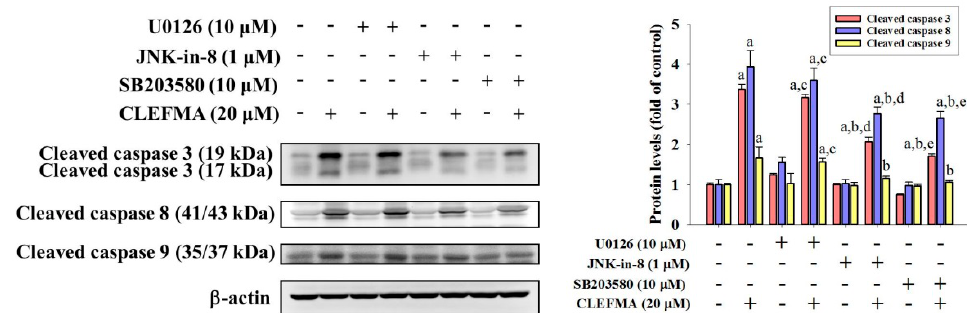
Figure 6. Effects of CLEFMA and inhibitors of ERK1/2 (U0126), JNK1/2 (JNK-in-8), and p38 (SB203580) on cleaved caspases 3, 8 and 9 expression of U2OS cells. Expressions of cleaved caspases 3, 8 and 9 after pretreatment with or without 10 μ M of U0126, 1 μ M of JNK-in-8, and 10 μ M of SB203580 for 1 h followed by 20 μ M or without CLEFMA treatment for an additional 24 h in U2OS cells were measured through Western blot analysis. Next, they were subjected to quantitative analysis. Results are shown as mean ± S.D.; n = 3. ANOVA analysis with Turkey’s posteriori comparison was used. Cleaved caspase 3: F = 502.398, p < 0.001; Cleaved caspase 8: F = 95.967, p < 0.001; and cleaved caspase 9: F = 10.543, p < 0.001. a: Significantly different, p < 0.05, when compared to control. b: Significantly different, p < 0.05, when compared to 20 μ M CLEFMA. c: Significantly